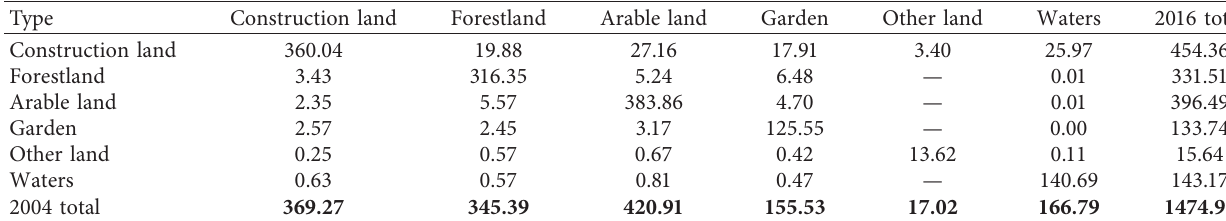
Figure 4: Land use change: (a) 2004, (b) 2008, (c) 2012, and (d) 2016. Table 4: Land use transfer matrix (2004–2016) (unit: km 2